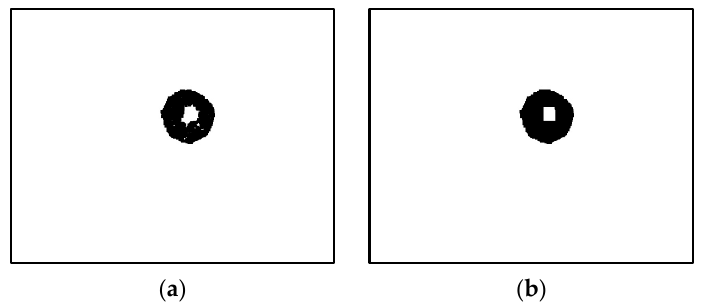
Figure 5. Image after opening/closing: ( a ) Image after 2 openings; ( b ) Image after 4